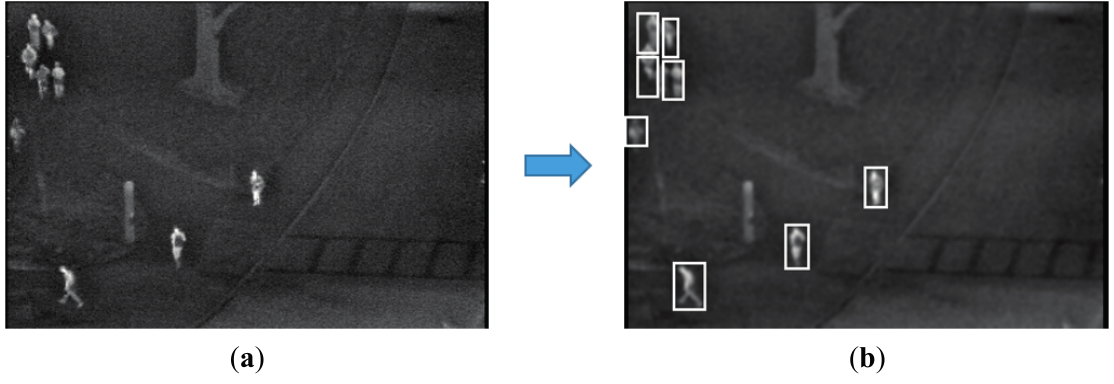
Figure 15. Detection error cases with the OTCBVS benchmark dataset: ( a ) original image; ( b ) result of the proposed